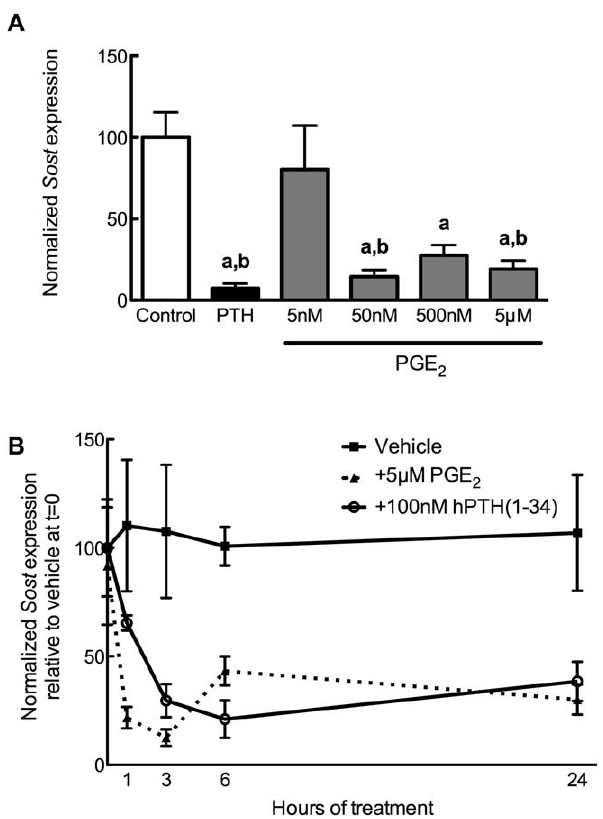
Figure 1. PGE 2 decreases Sost expression. ( A ) Human PTH(1–34) (100 nM) or PGE 2 (5 nM–5 m M) or vehicle control (0.05% DMSO) was added to UMR 106.01 cells for 3 hours. Total RNA was collected and analyzed for Sost and Rpl32 expression by qPCR. n=6–10 samples per treatment. a indicates p , 0.05 versus Control; b indicates P , 0.05 versus 5 nM PGE 2 . ( B ) Sost mRNA expression was quantified in UMR 106.01 cells after 0, 1, 2, 3, 6, or 24 hours treatment with 5 m M PGE 2 or vehicle control. n=4 samples per treatment. For PGE 2 , each time point is significantly different ( p , 0.05) from Control, while for PTH, every time point except 1 hr is significantly different ( p , 0.05) from